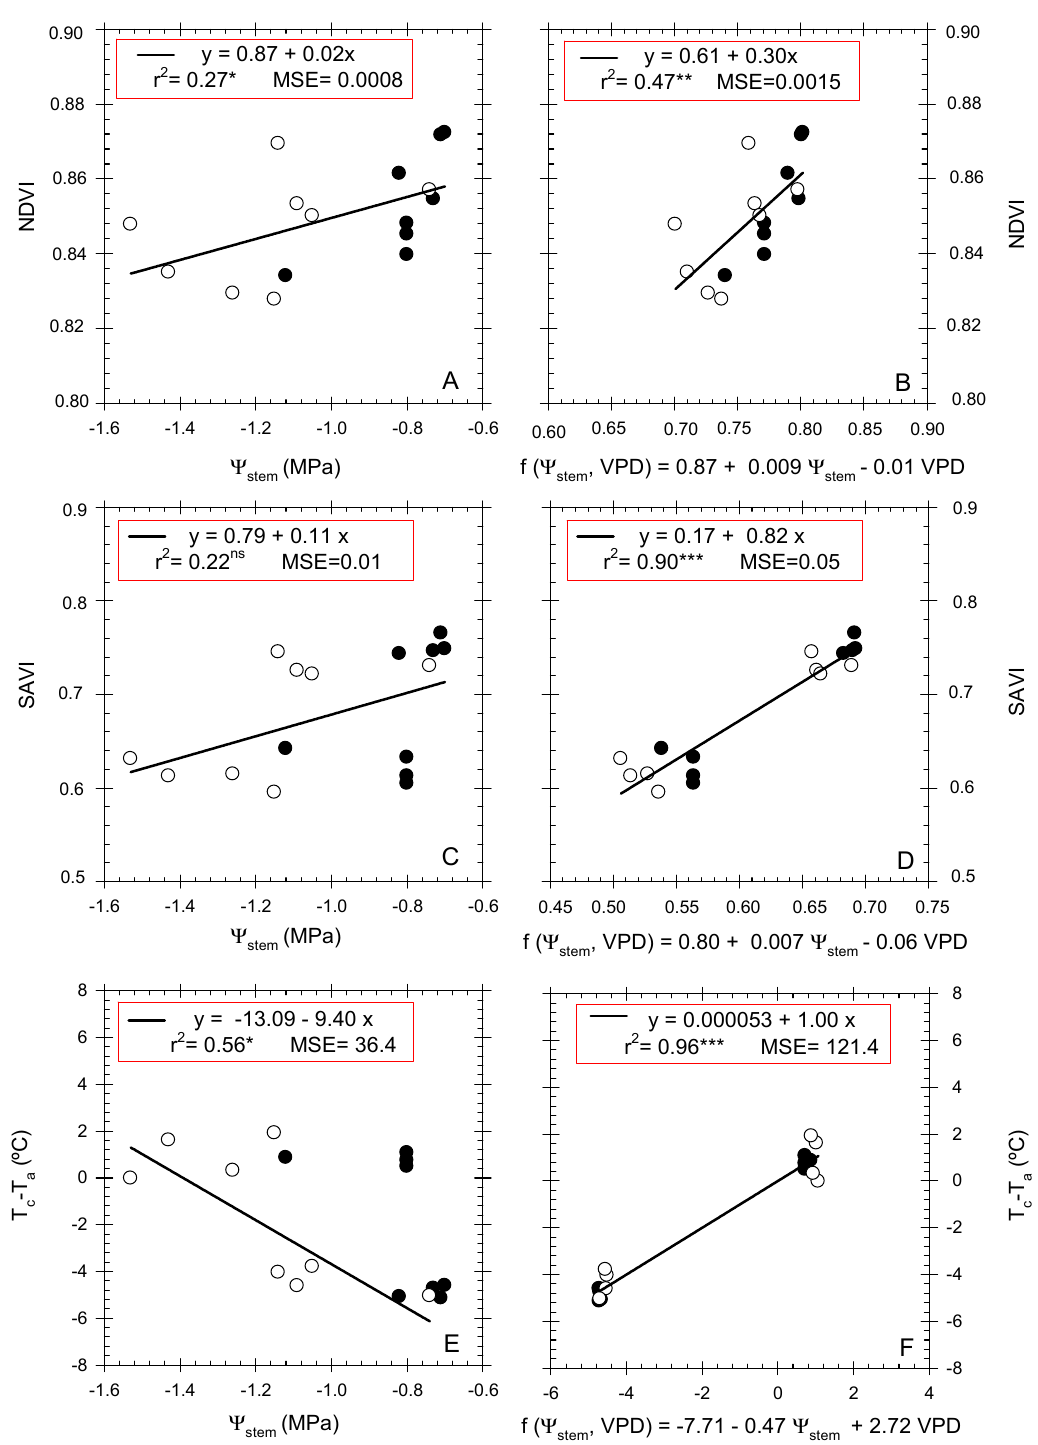
Figure 7. Relationship between stem water potential ( Ψ stem , MPa) and ( A ) normalized difference vegetation index (NDVI), ( C ) soil adjusted vegetation index (SAVI), and ( C ) canopy to air temperature difference (T c -T a , ºC), and between the function of Ψ stem and vapor pressure deficit (VPD) and ( B ) NDVI,( D ) SAVI, and ( F ) T c -T a in control ( ● ) and PDI (o) treatments at t1 (10:00 GTM) and t2 (12:00 GTM) flight times. Each point corresponds to selected trees. ns, not-significant; * p ≤ 0.05, ** p ≤ 0.01; *** p ≤ 0.001, MSE mean square error.